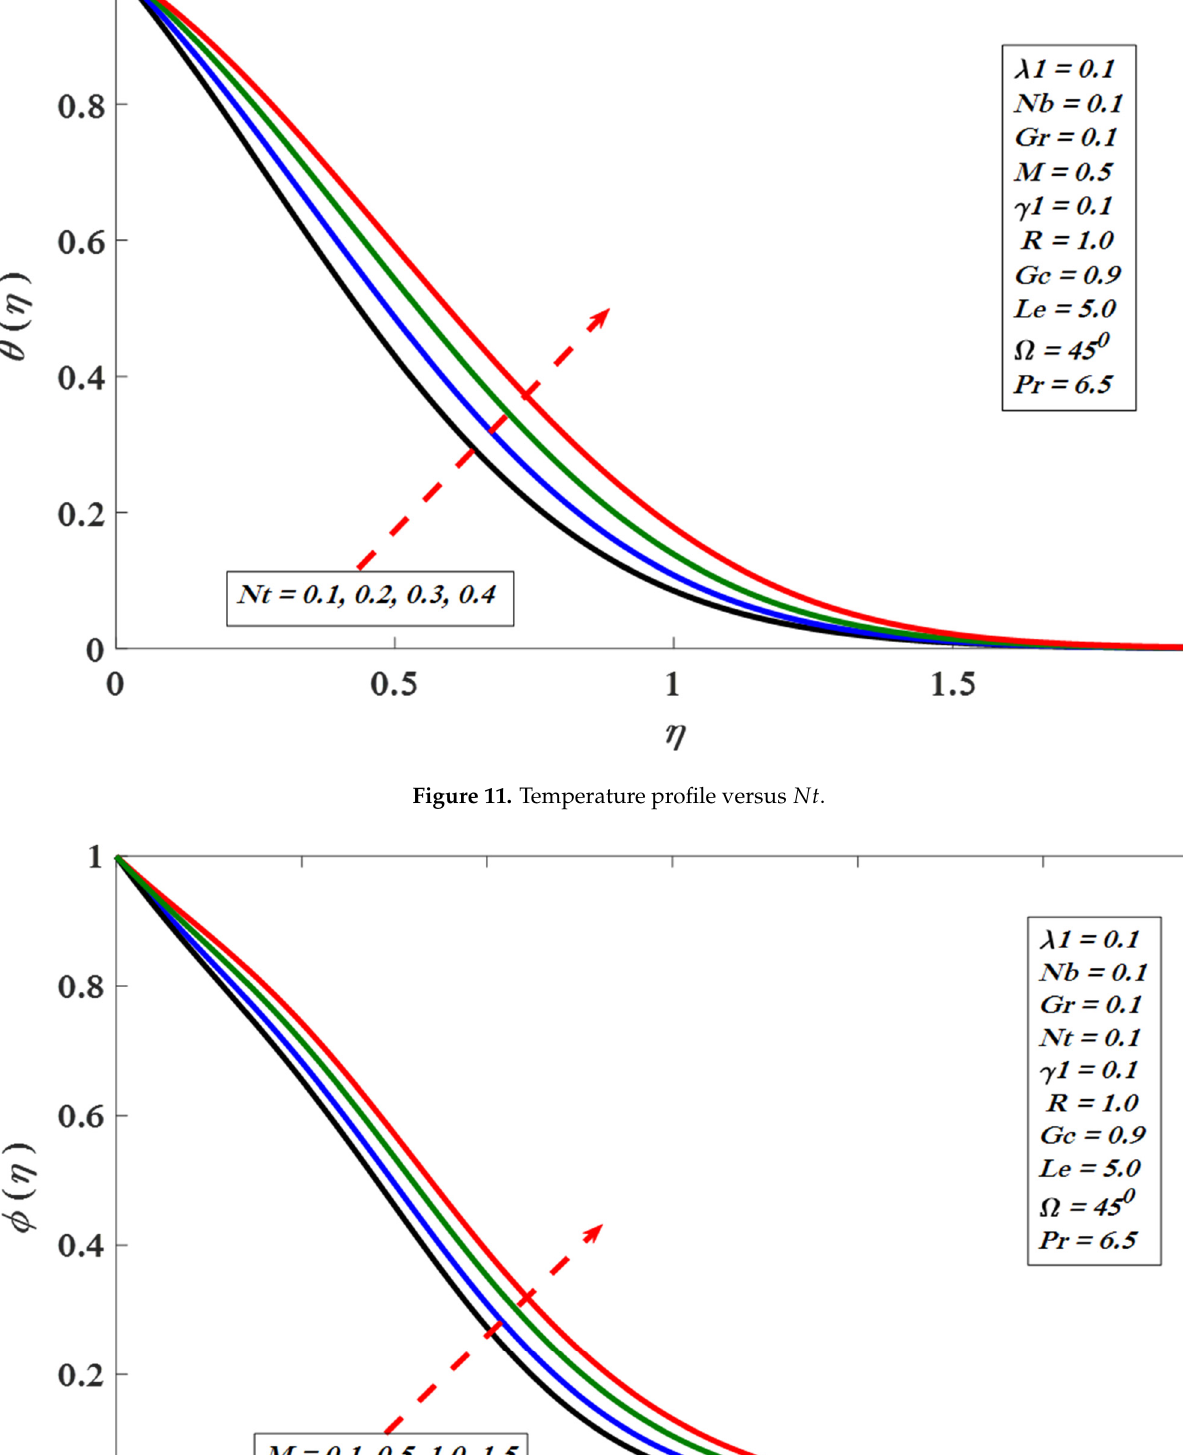
Figure 10. Temperature profile versus . Nb